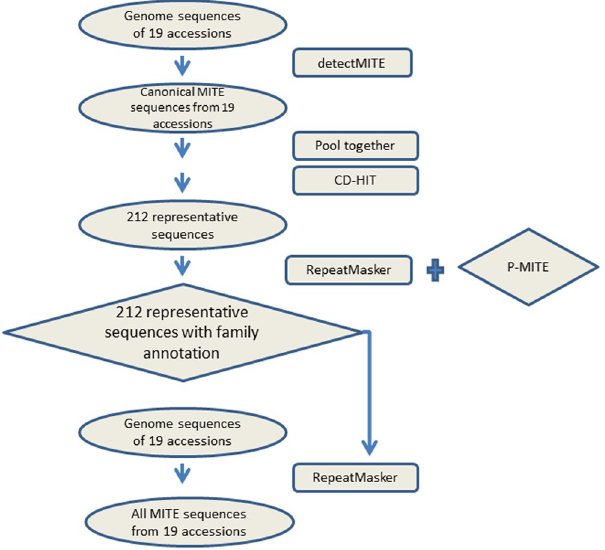
Figure 1. Flowchart of the pipeline for MITE identification in 19 Arabidopsis thaliana